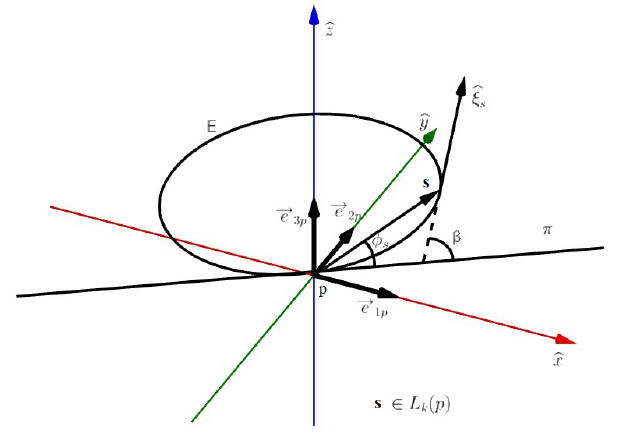
Fig. 1: Geometric representation of the angles φ s , β and ξ s of an arbitrary point s . unitary vector b